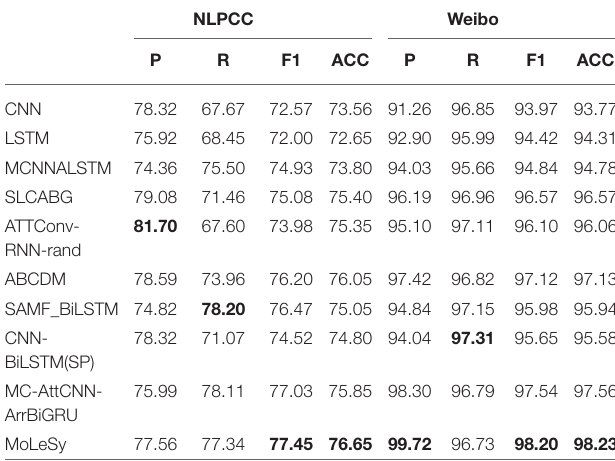
Bold values are the maximum number in each column.